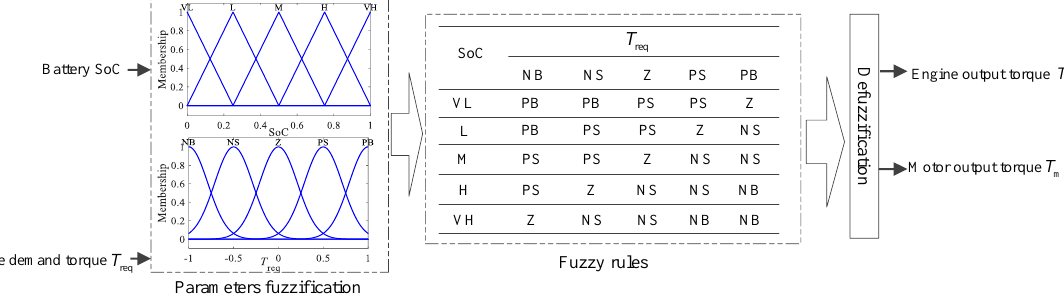
Figure 11. The design principle of fuzzy RB EMSs